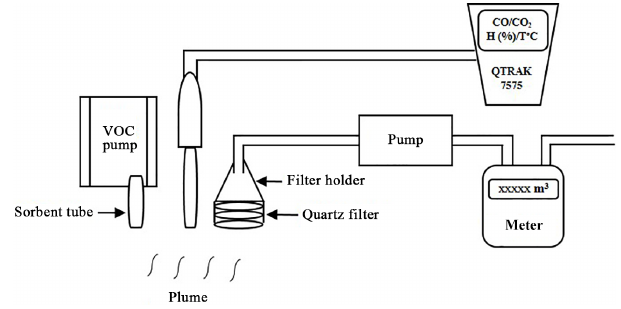
Figure 1. Schematic view of field sampling